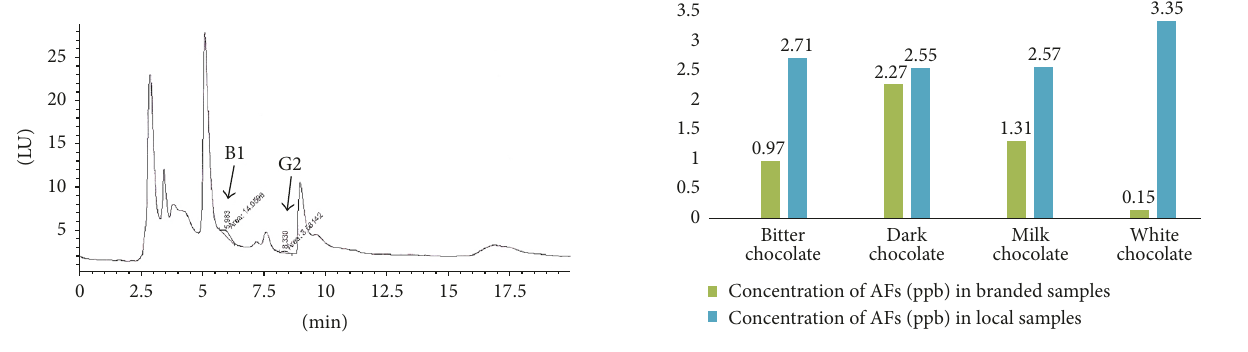
Figure 4: HPLC chromatogram of local chocolate sample.